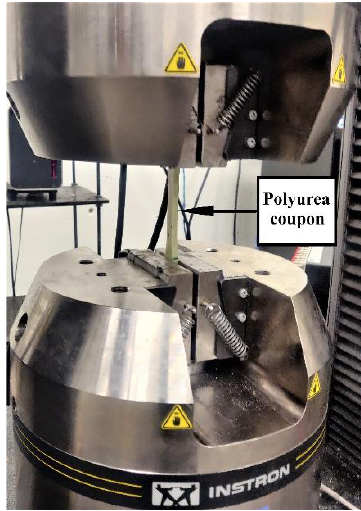
Figure 3. Test Setup featuring a typical die type I coupon specimen installed in the Instron UTM.